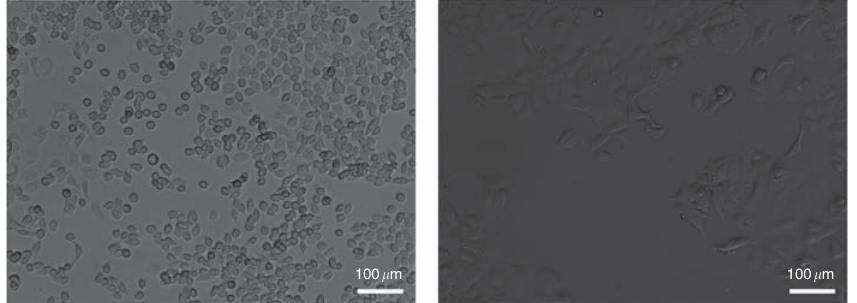
Figure 1. Samples of MDA-MB- 468 and MCF7 breast cancer cell lines that were used in training the convolutional neural